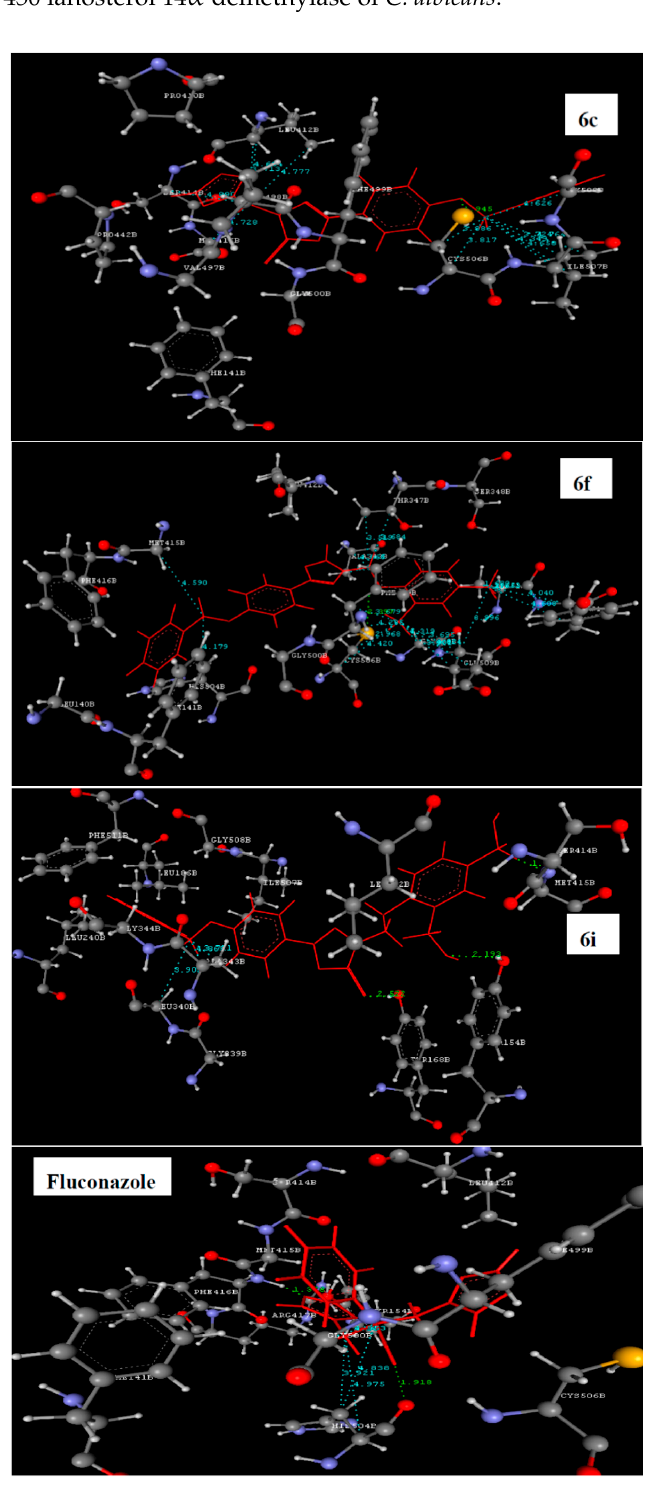
Figure 1. Docking of compounds 6c , 6f , 6i and standard fluconazole. Ligands are shown in red color. Hydrogen bonds are shown in green color. Hydrophobic bonds are shown in sky blue color.